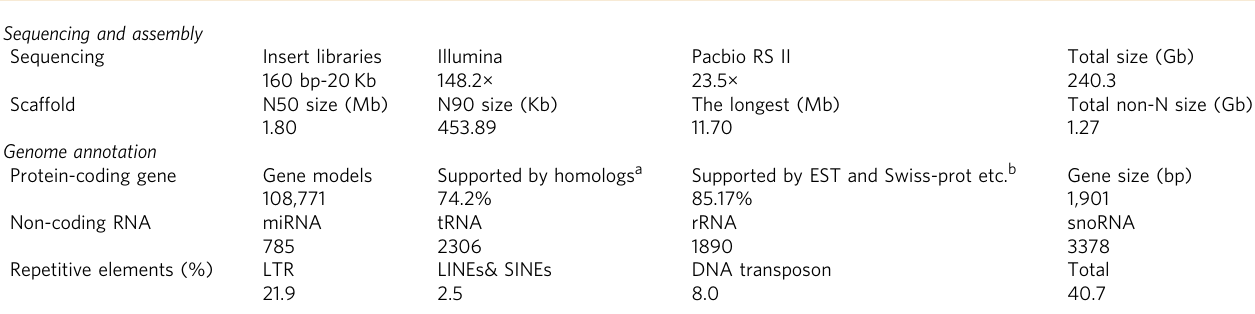
Table 1 Summary of the genome assembly and annotation of E. crus-galli Sequencing and assembly